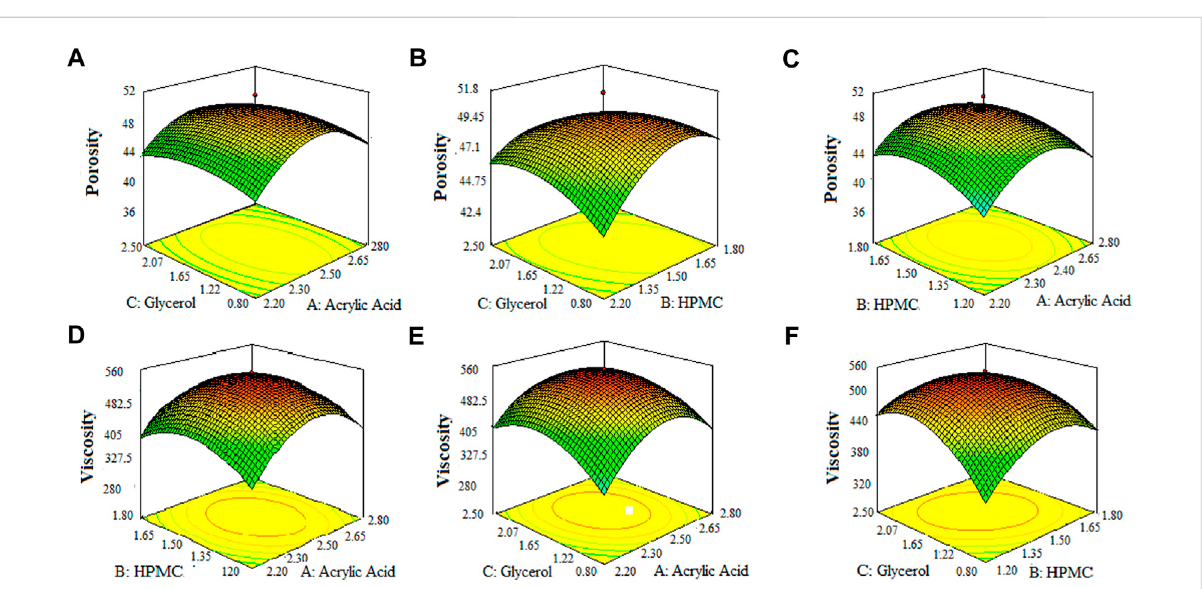
FIGURE 1 3D surface plots indicating the effect of various concentration of hpmc-k100, glycerol and acrylic acid on porosity (A – C) and viscosity of SPHs (D – F) .